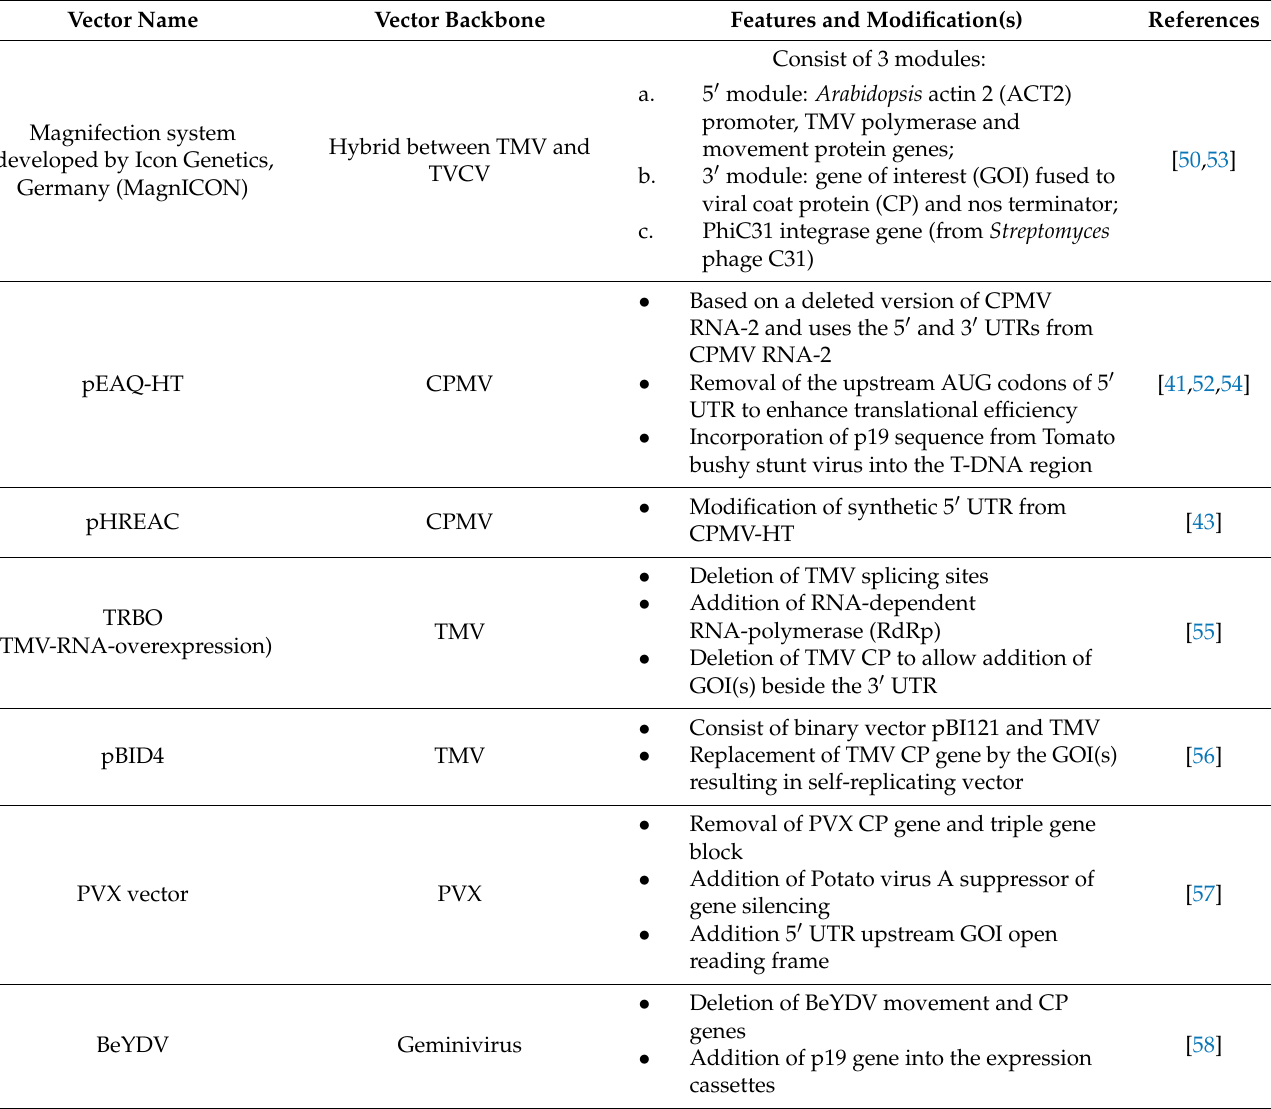
Table 2. List of commonly used RNA and DNA plant virus-based deconstructed vectors for Agrobac- terium tumefaciens -mediated transient transformation in planta